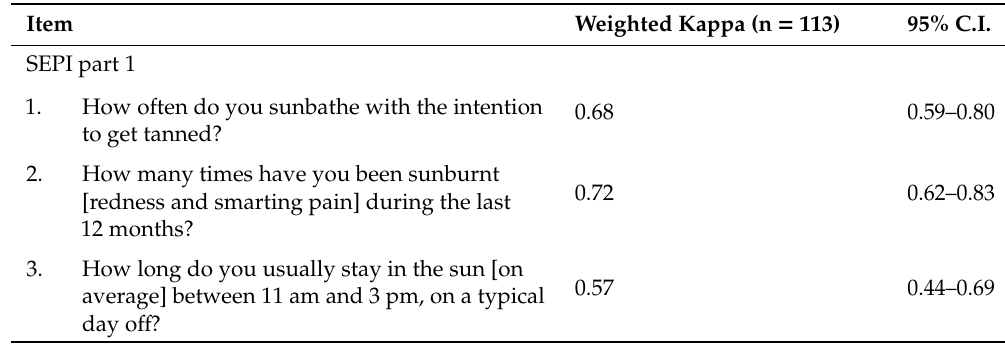
Table 2. Stability over time, by Cohen’s weighted kappa, between the SEPI question items at baseline and at follow-up, and its 95% confidence